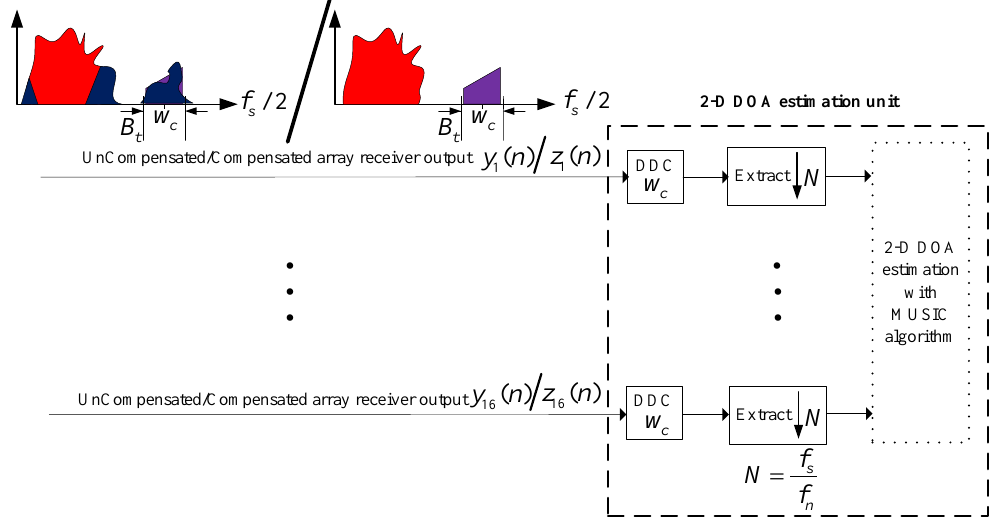
Figure 11. Two-dimensional direction-of-arrival (2-D DOA) estimation structure.